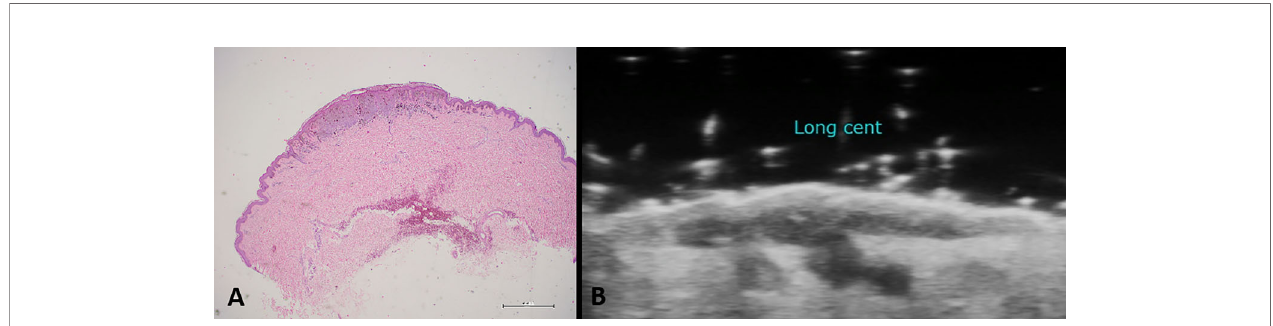
FIGURE 1 | Histological specimen (A) and ultrasound examination (B) in case of cutaneous melanoma. High-frequency probes are useful for the determination of the ultrasound Breslow index, which means evaluating the depth of tumor